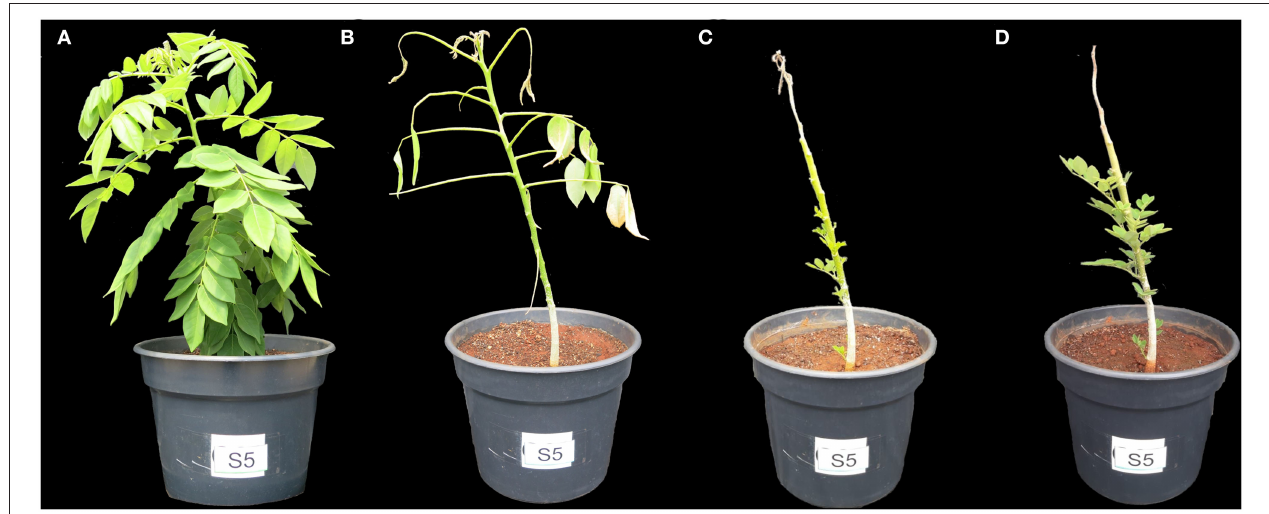
FIGURE 2 | Timeline of the adaptation response in gliricidia plant under salinity stress. Plants at 0.8g of NaCl per 100g of the substrate. After 1 (A) , 5 (B) , 23 (C) , and 34 (D) days of